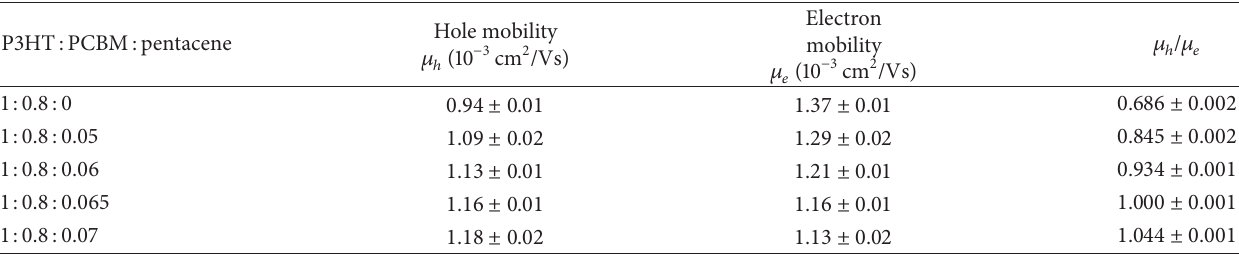
Table 1: The hole mobility and electron mobility of the hole-only devices and the electron-only devices with various pentacene doping